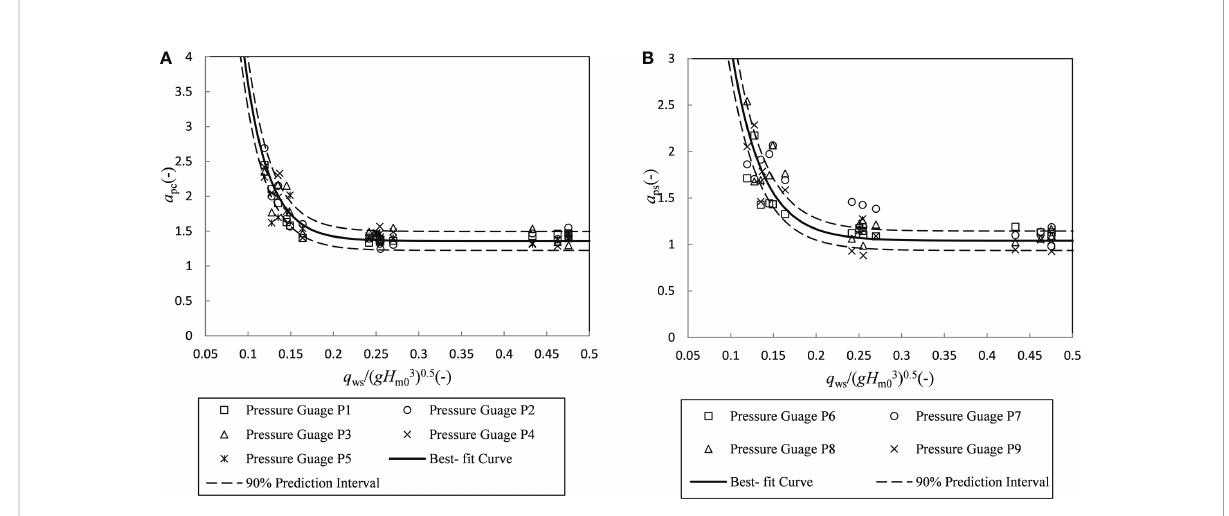
FIGURE 11 Best- fi t equations for Weibull factor a p : (A) on the crest; (B) on the upper part of landward slope.